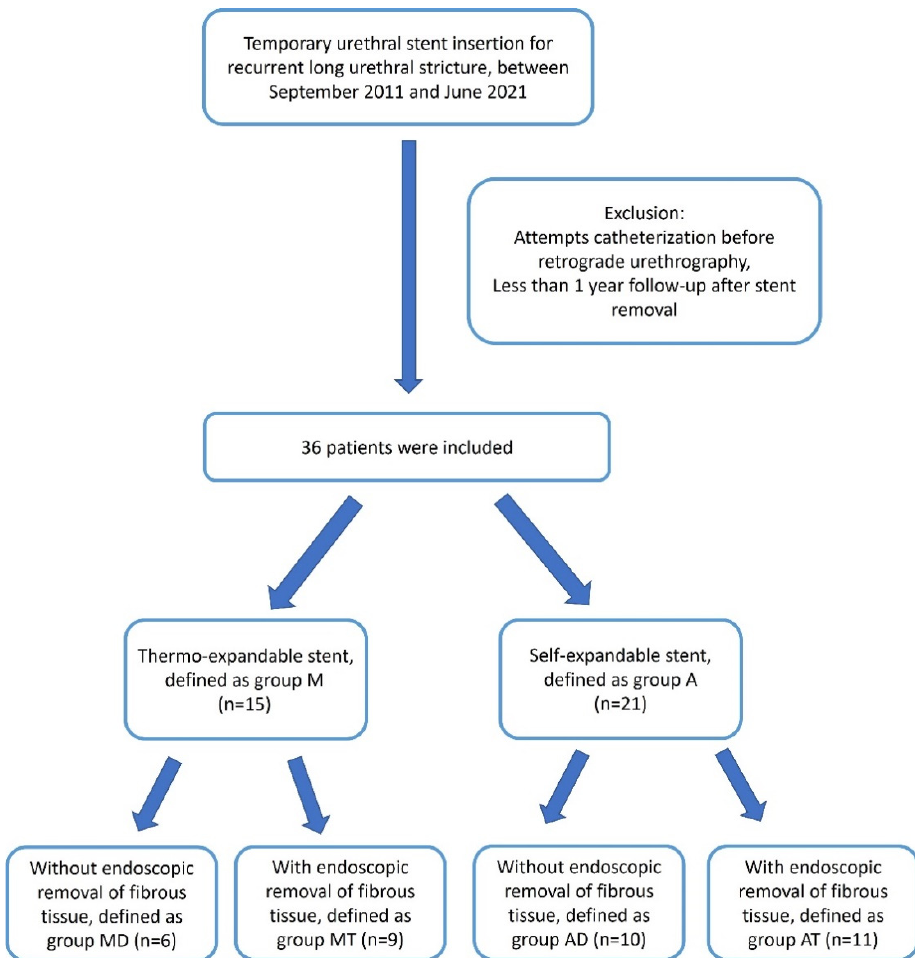
Figure 1. Flow-chart for patient selection and their division into groups.